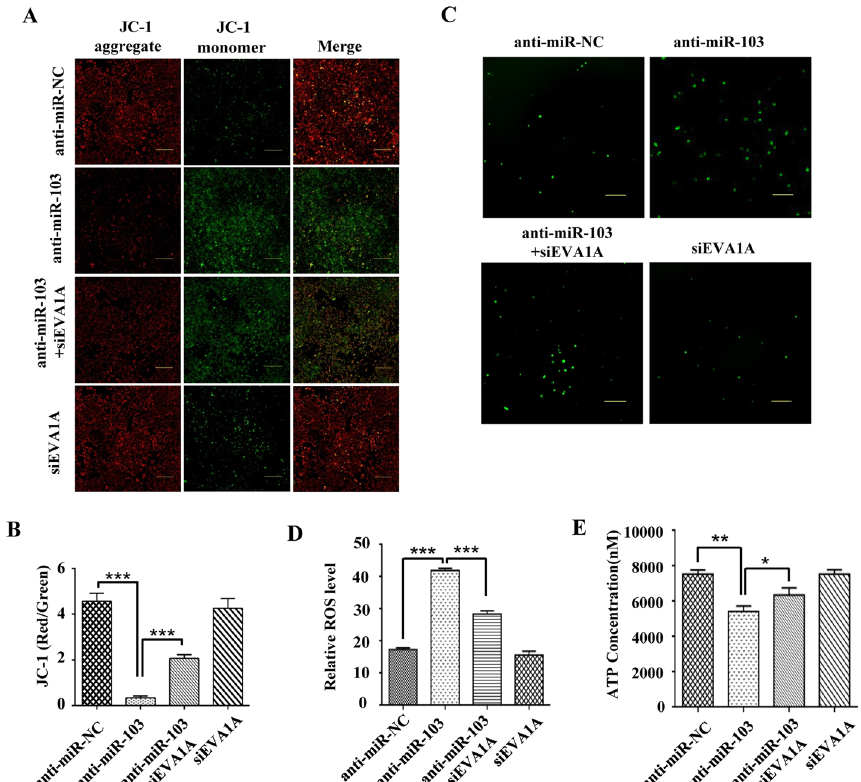
Fig. 8 Inhibition of miR-103a-3p triggers EVA1A-dependent mitochondrial dysfunction. A , B Hccl-M3 cells were transfected with miR-103a-3p inhibitor or siRNA of EVA1A, or both of them. The changes of mitochondrial membrane potential were evaluated by JC-1 staining. C , D Intracellular ROS levels were determined by DCFH-DA probes. Scale bars, 200 μm. E Intracellular ATP levels were detected by the ATP Assay Kit. Data are presented as means SD from three independent experiments. * P < 0.05, ** P < 0.01, ± *** P <